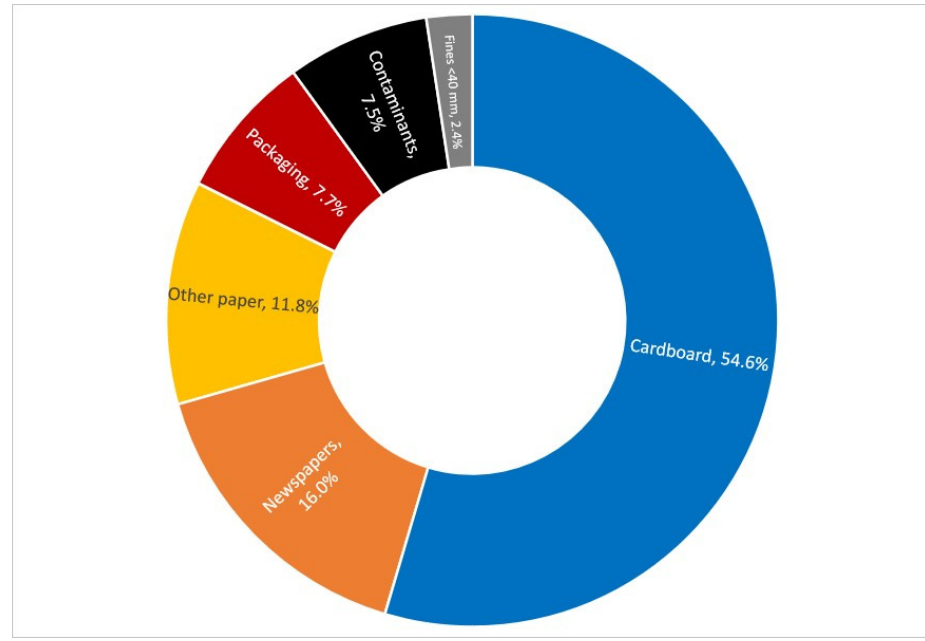
Figure 5. Composition of separately collected paper and cardboard—main categories.